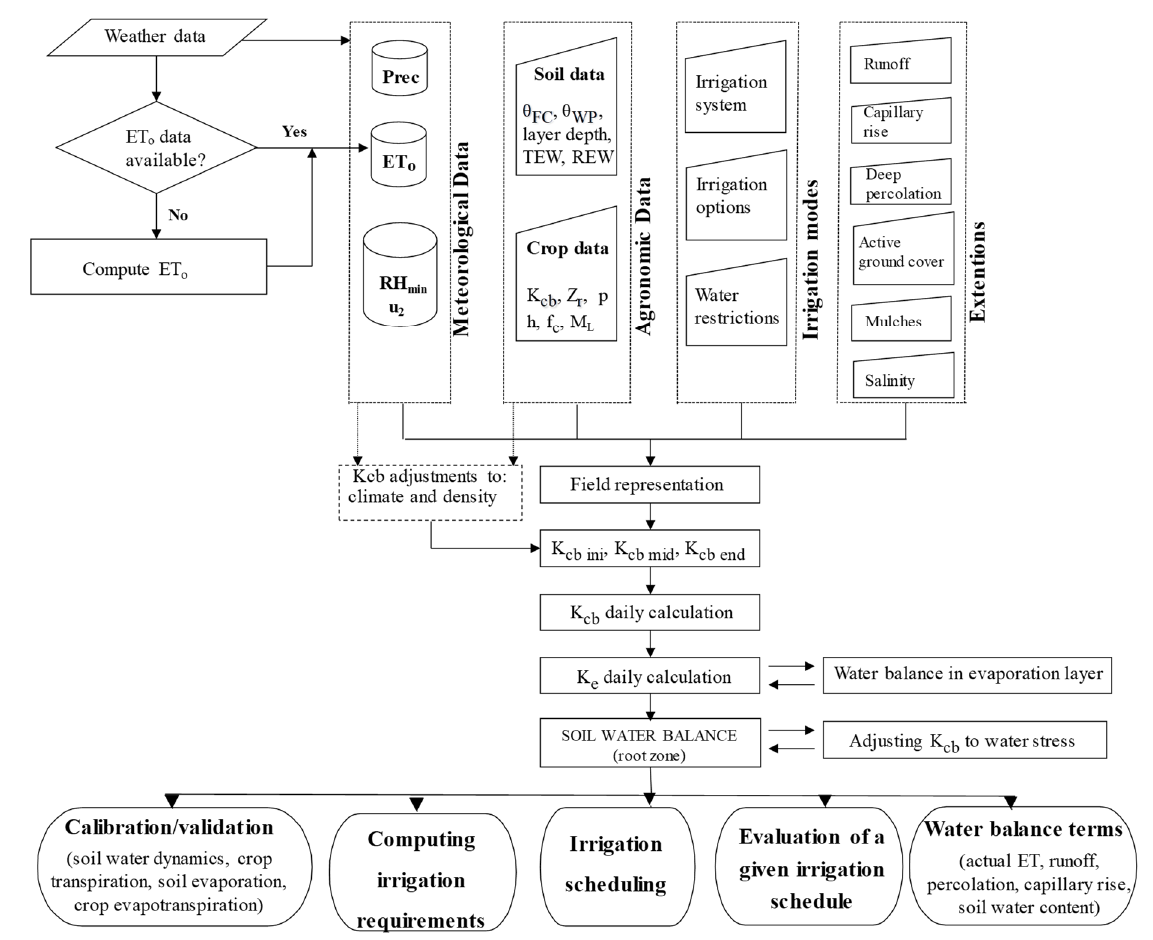
Figure 3. Schematic representation of SIMDualKc model (Adapted with permission from Rosa et al. [45]. 2012, Elsevier).